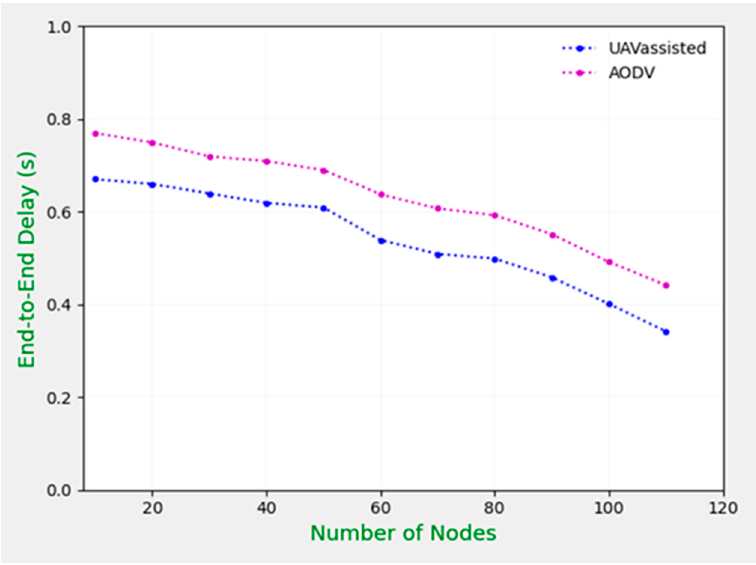
Figure 9. End-to-end delay.